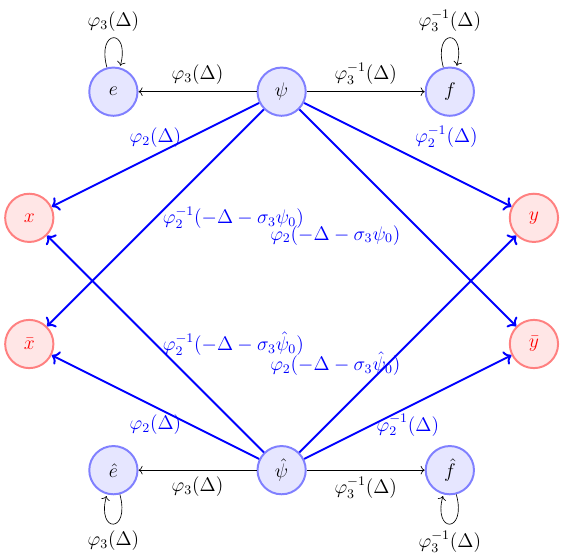
Figure 3 . The OPEs with the Cartan generators ( u ) and ^ ( u